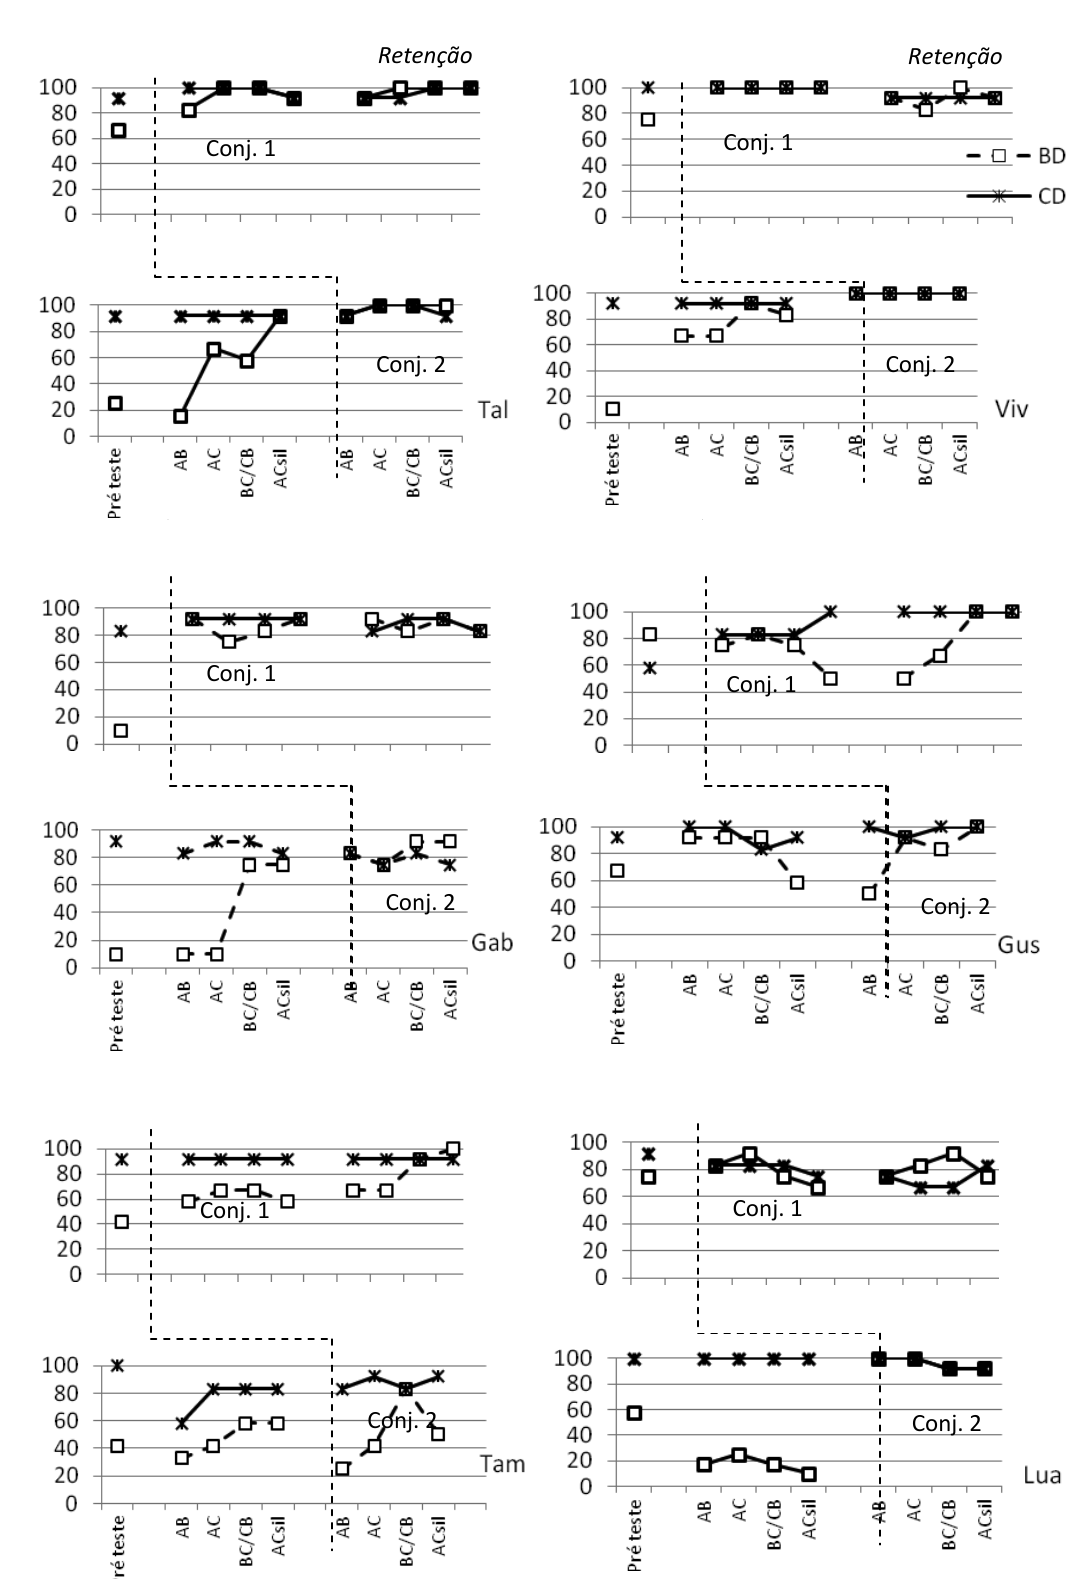
Figura 2. Porcentagem de acertos de participantes individuais nas sucessivas sondas de nomeação de fi guras (BD – quadrados